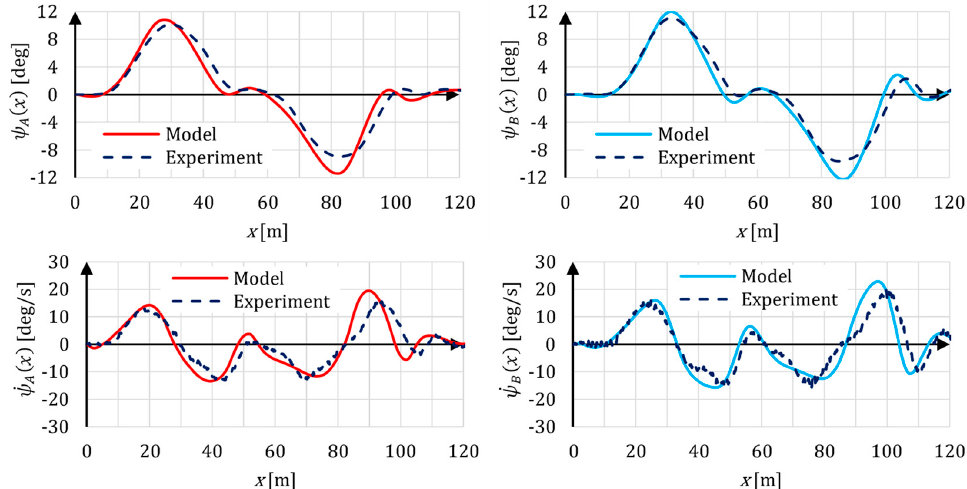
Figure 11. Comparison of results of the experimental and simulation tests of the CT unit performing a double lane-change maneuver with a speed of v = 60 km/h (left: motorcar; right: trailer).